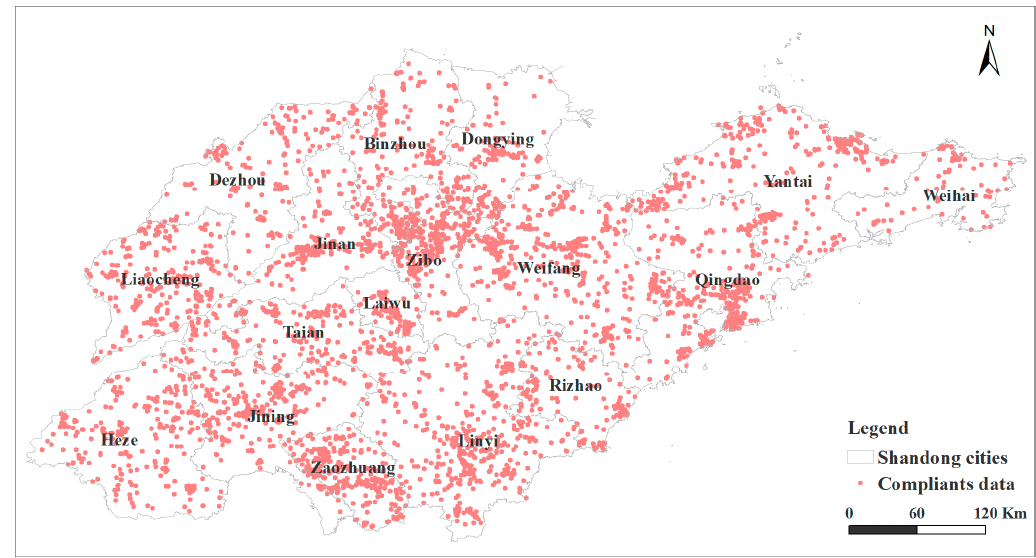
Figure 2. Spatial distribution of air pollution complaint data in Shandong Province from 2012 to 2017 .